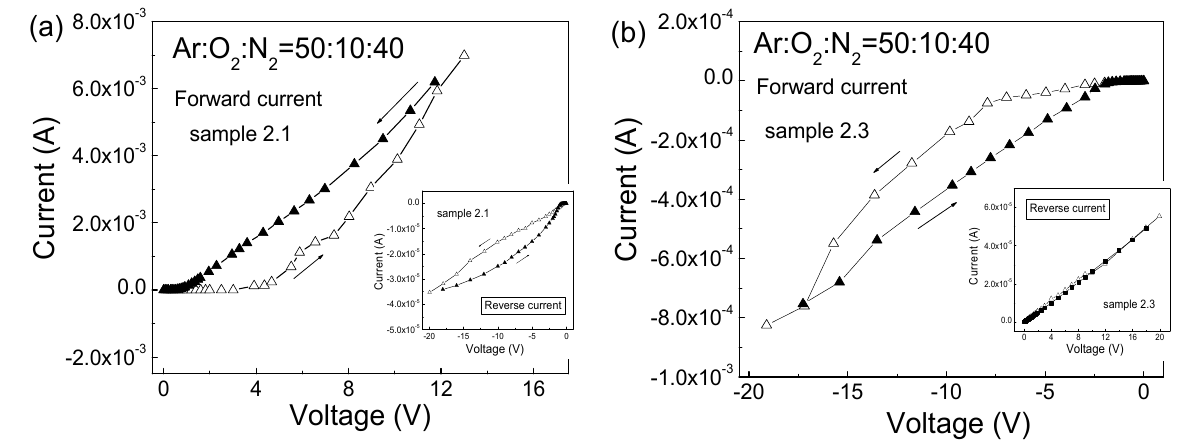
Figure 5. Room temperature I–V characteristics of MIS structures with ZnO:N films, deposited at Ar:O 2 :N 2 = 50:10:40 (sample 2.1) ( a ) and after RTA at 550 °C (sample 2.3) ( b ). The initial and return stages of the I–V measurements are denoted with empty and full triangles, respectively. The corresponding I–V curves in the reverse direction are given as insets.